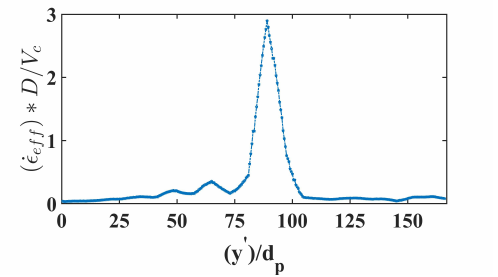
Figure 6. Sample line along which the strain rate profile has been measured in our experiments